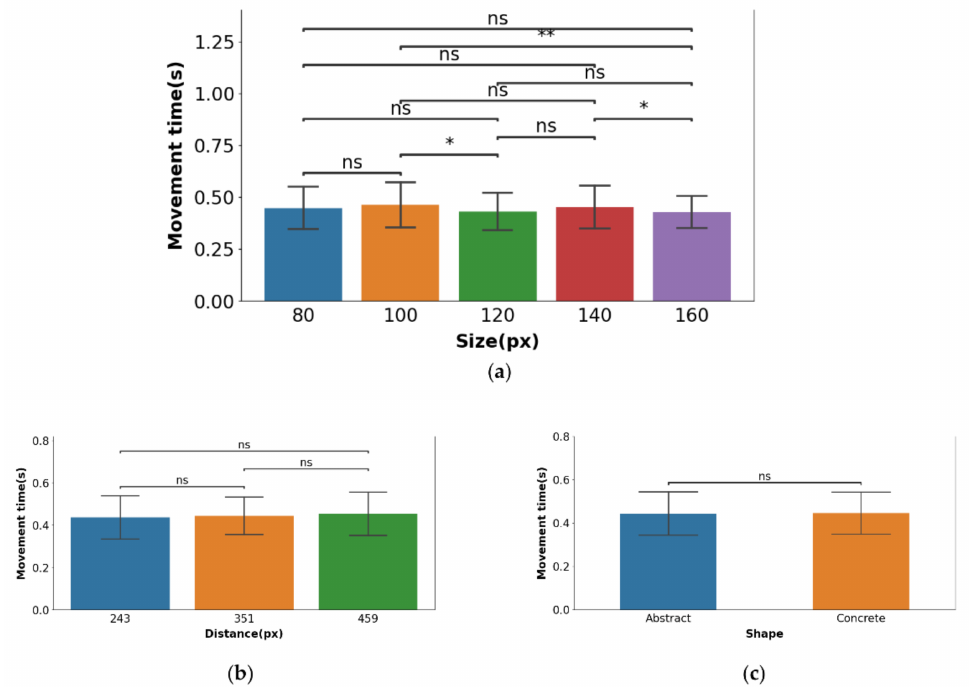
Figure 12. ( a – c ): Bar graphs of movement times and post hoc multiple comparisons of main effect levels for the size, distance, and shape variables, respectively. The line between levels indicates the results of the t-test at the level of the two variables, ‘ns’ indicates that no significant differences are presented between samples, ‘*’ indicates that significant differences are presented between samples, and ‘**’ indicates the higher significance.